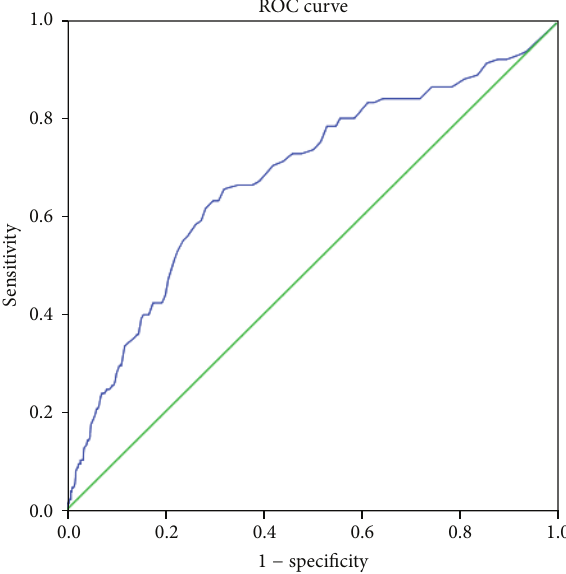
Figure 1: ROC curve for PIRI, workers with